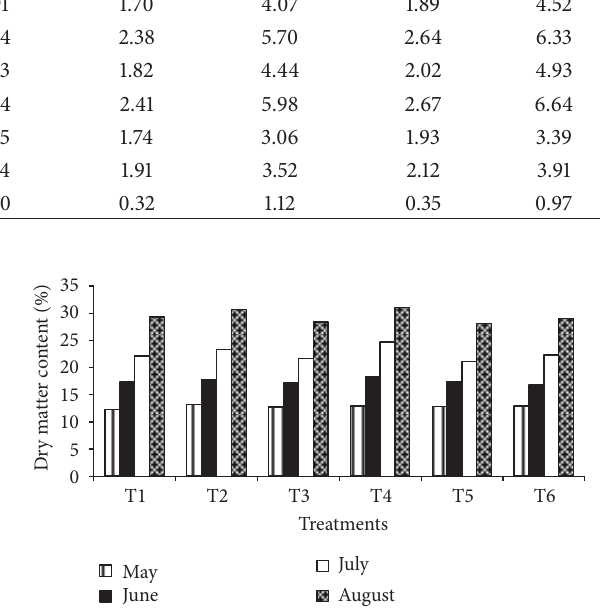
Figure 1: Nut dry matter accumulation under N&K fertigation in almond.